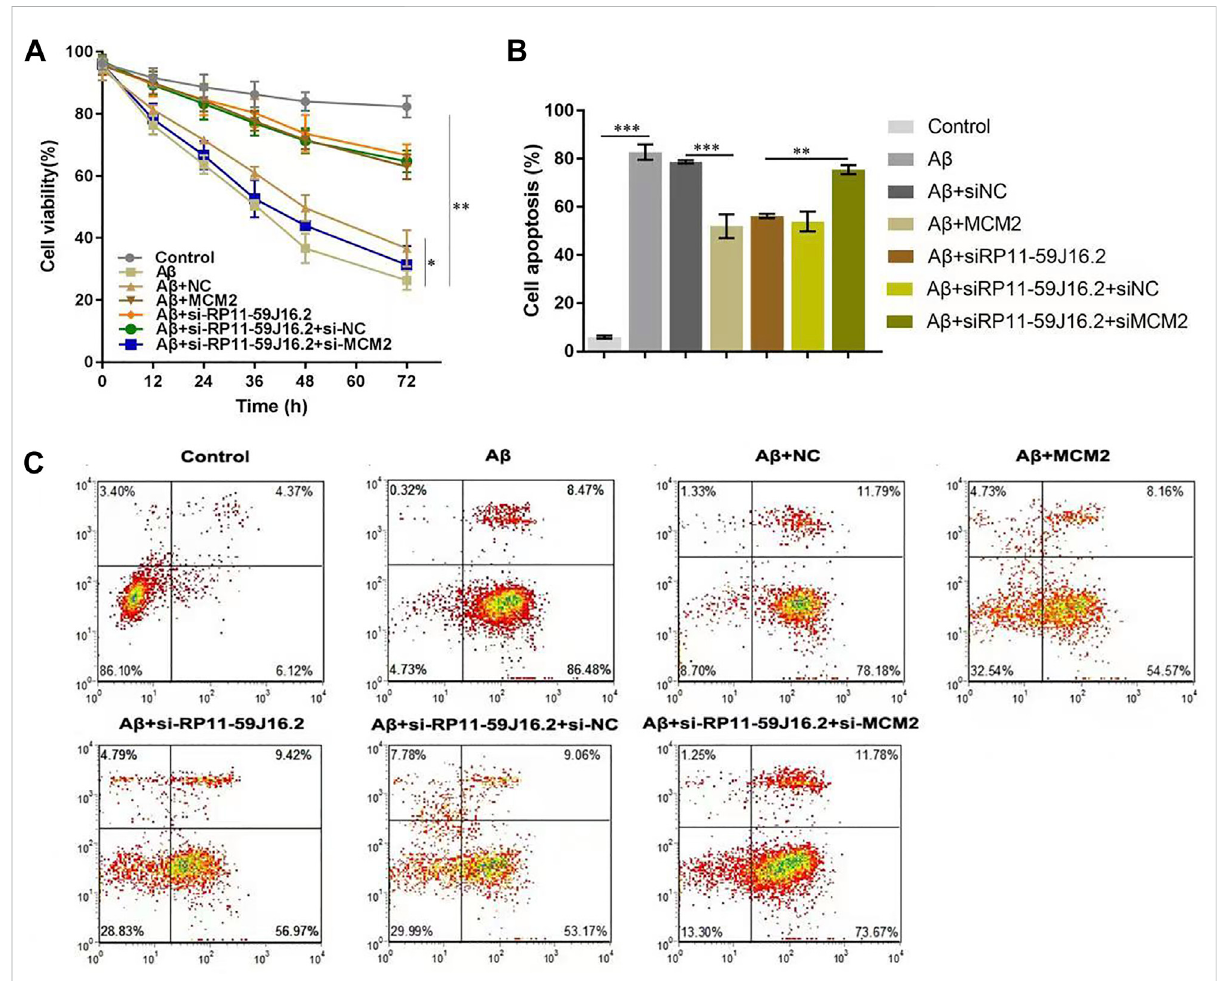
FIGURE 5 RP11-59J16.2 affect the neuronal damage of SH-SY5Y cells induced by A β by targeting MCM2. After treatment with 10 μ M A β 1-42 for 24h, SH- SY5Y cells were transfected with pcDNA-NC, si-RP11-59J16.2, pcDNA-MCM2, si-RP11-59J16.2 + si-NC and si-RP11-59J16.2 + si-MCM2 to detect cellviability (A) andapoptosis(B,C).(A)CCK-8assaywasusedtodetectthechangesofcellviabilityineachgroup.Cellviabilityincreasedsigni fi cantly in si-RP11-59J16.2 and MCM2 transfection group compared to A β treatment group. It reduced signi fi cantly after transfection of si-RP11- 59J16.2+si-MCM2. (B,C) FlowcytometrywasusedtoexploretheeffectsofRP11-59J16.2andMCM2onapoptosisofSH-SY5Ycells. Transfectionof si-RP11-59J16.2 or MCM2 signi fi cantly reduced the apoptosis of SH-SY5Y cells after A β treatment. The cell apoptosis in si-RP11-59J16.2+ si-MCM2 group was signi fi cantly increased compared with si-RP11-59J16.2 group. The experiment was repeated three times in each group, * p < 0.05; ** p < 0.01; *** p <